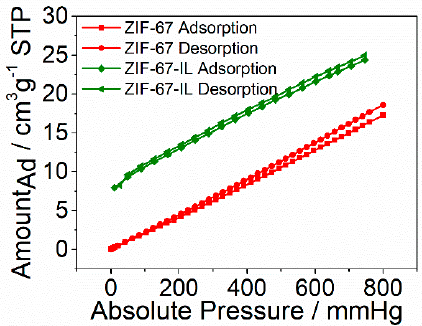
Figure 7. Carbon dioxide adsorption capability under different pressures at 25 °C for ZIF-67 and